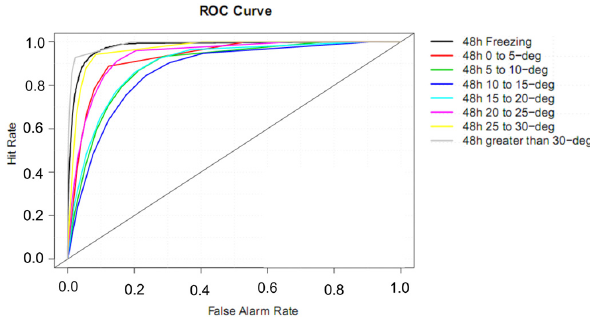
Fig. 10. Relative operating characteristic (ROC) diagrams for eight temperature categories ranging from “equal to 0 ◦ C” out to “above 30 ◦ C” with 5 ◦ C